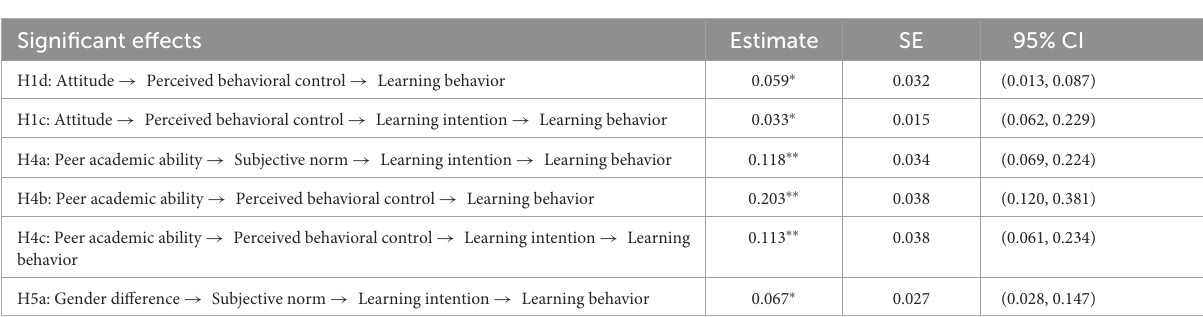
TABLE 3 The results of examined effects using bootstrapping